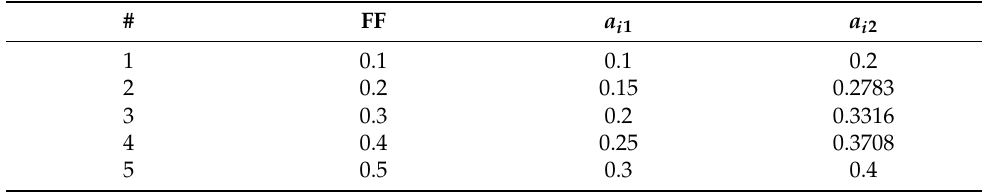
Table 2. The dimensions of the phononic crystals with 4 gradient square inclusions.